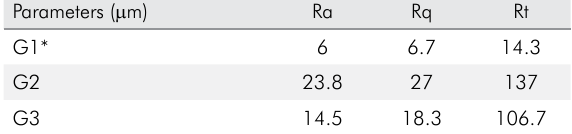
Statistical analysis was performed using ANOVA test with Bonferroni post-test of revealed statistical significance. *p < 0.05, among values from three groups (G1 < G2 =